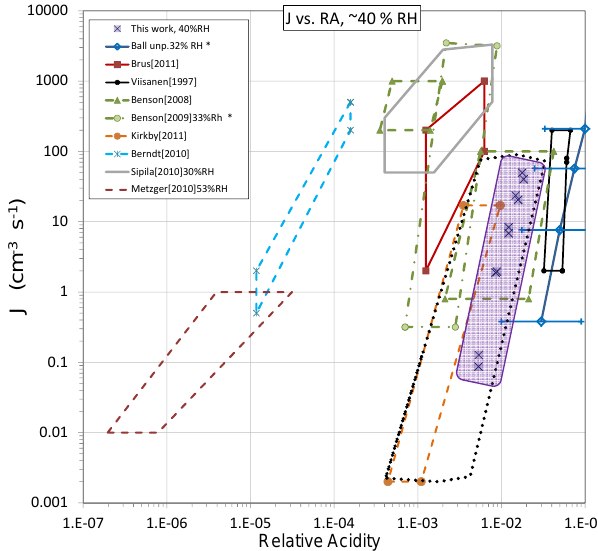
Fig. 7. As in Fig. 6 but nucleation rate J is plotted against RA for 40% RH. For two studies (denoted with *) with results at 32 and 33% RH where RH dependence was quoted, J was cor- rected to 40% RH equivalent using PD 2 = 6. For three other stud- ies conducted at RH significantly different from 40%: the Sipila et al. (2010) results for 30% RH if corrected in a similar man- ner would cause further divergence while results for Metzger et al. (2010) (53%) and Berndt et al. (2010) (45%) would diverge less ( J lowered by a factor of 4 and 2